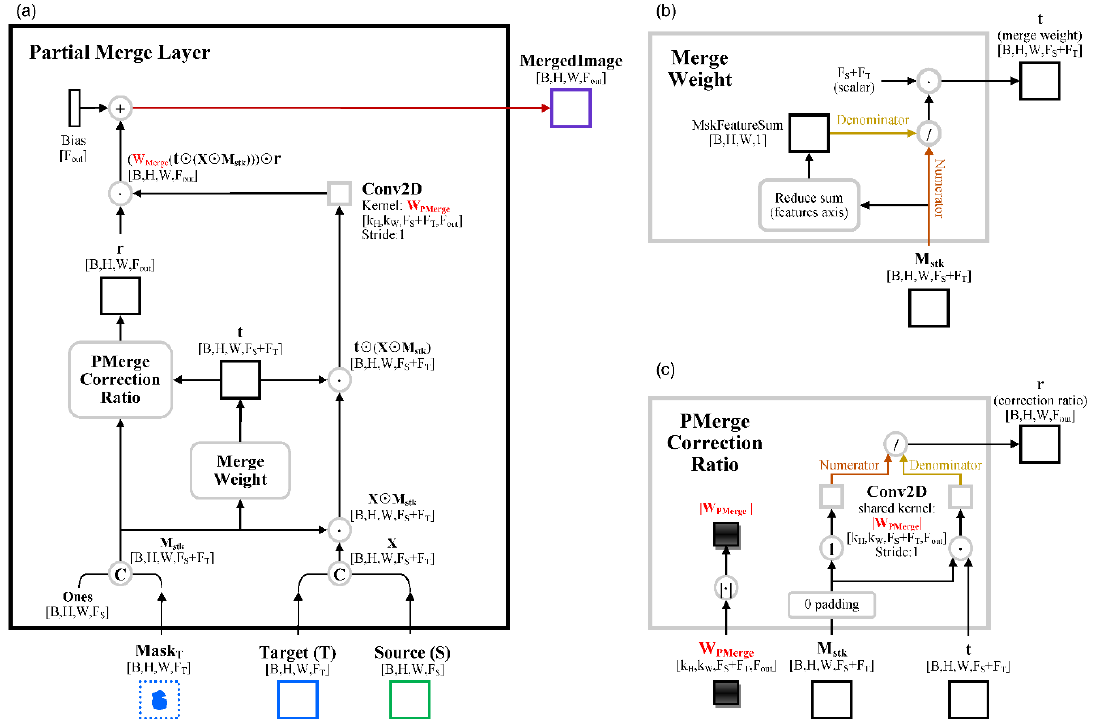
Figure 5. The flowchart of a SAPC2 Partial Merge layer (PMerge) ( a ); the Merge Weight submodule ( b ); and the PMerge Correction Ratio submodule ( c ).